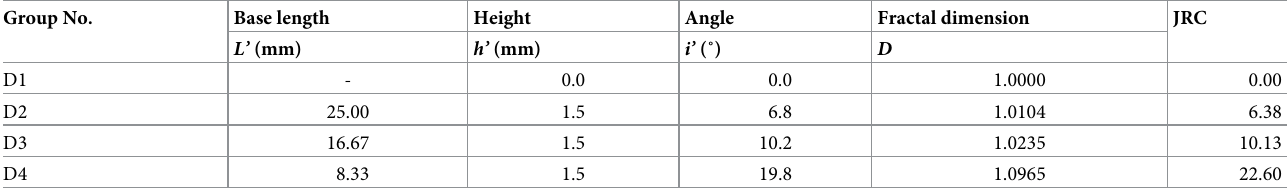
Table 1. Geometrical parameters and JRC values of the joint profiles for samples D1-D4. Group